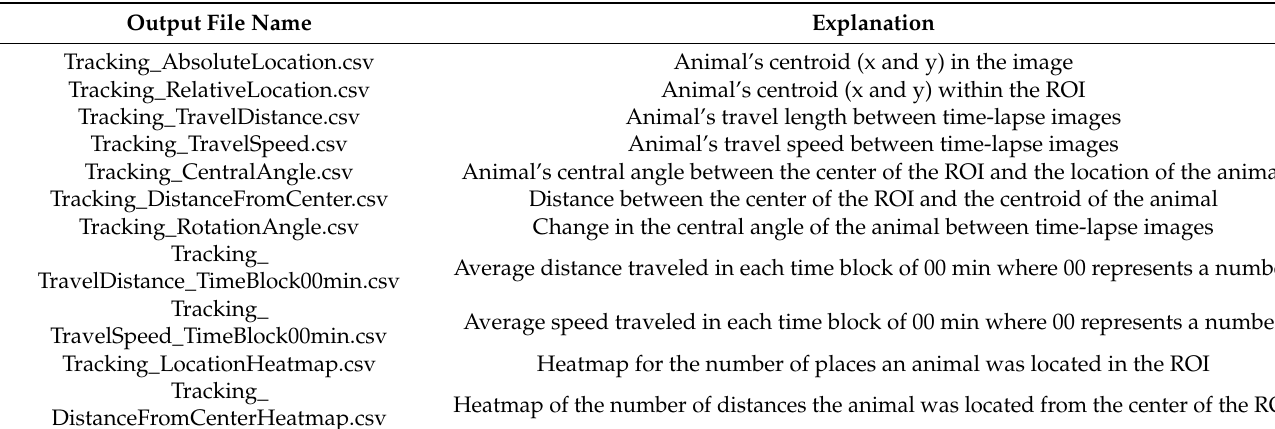
Table 1. Analysis output files generated by